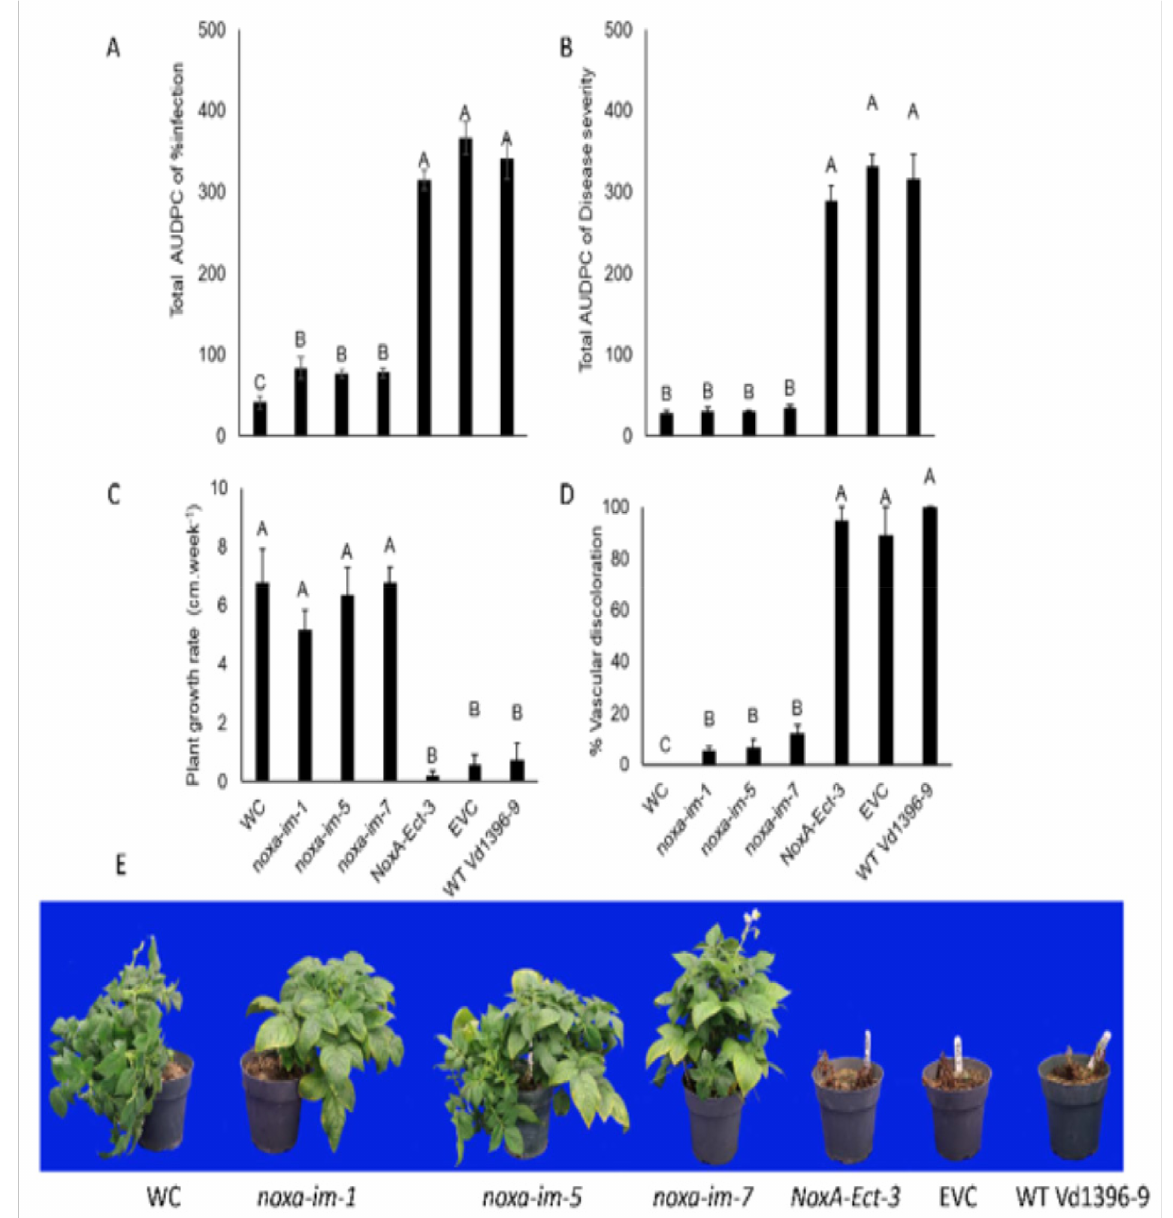
Figure 5. Pathogenicity test of noxa mutants on susceptible potato cultivar (Kennebec) in 2017. ( A ) Total AUDPC of percentage of infection. ( B ) Total AUDPC of disease severity. ( C ) Growth rate of potatoes. ( D ) Percentage of vascular discoloration. ( E ) Kennebec potatoes infected by noxa mutants at six weeks after infection. Error bars refer to standard error. The LSD post hoc test was performed to determine which differences are significant among variable means. Bars ( n = 5) with different letters indicate significant differences ( p <